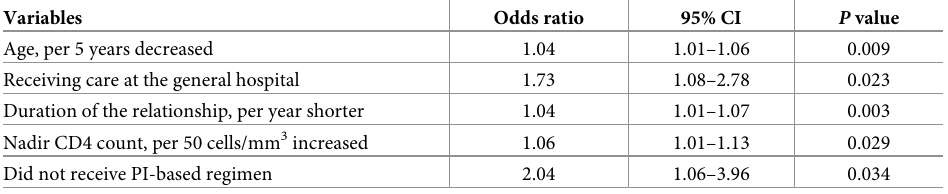
Table 3. Index HIV-infected patient factors associated with serodiscordant relationships by multivariate logistic